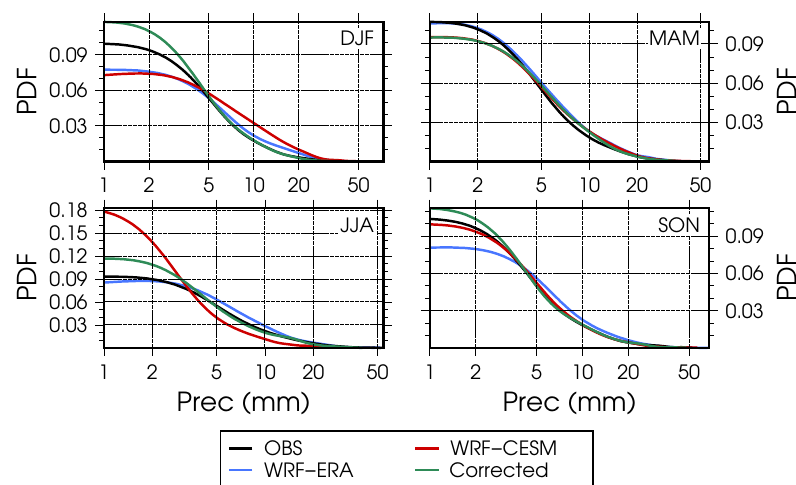
Figure 7. Estimated probability density functions (PDFs) of daily precipitation averaged over Switzerland. Each panel depicts the result for a season, and different colours are representative of the results for different datasets according to the choice in Fig. 5. Note the logarithmic scale in the x axis, which precludes the area below all curves being